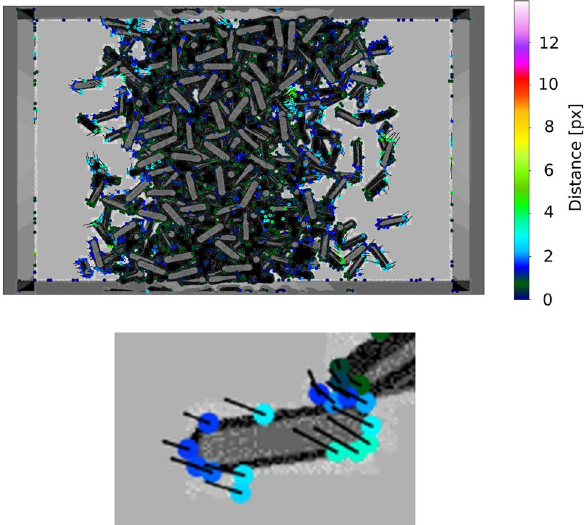
Figure 5. Example of feature displacement detection from two consecutive frames (visualization by the PyTrx package). Small black lines show the directions of feature displacement vectors, while dot colors correspond to the distance (lengths of the displacement) in pixel. The first frame serves as a background. The bottom image is a zoomed-in detail, showing one of the particles and the detected